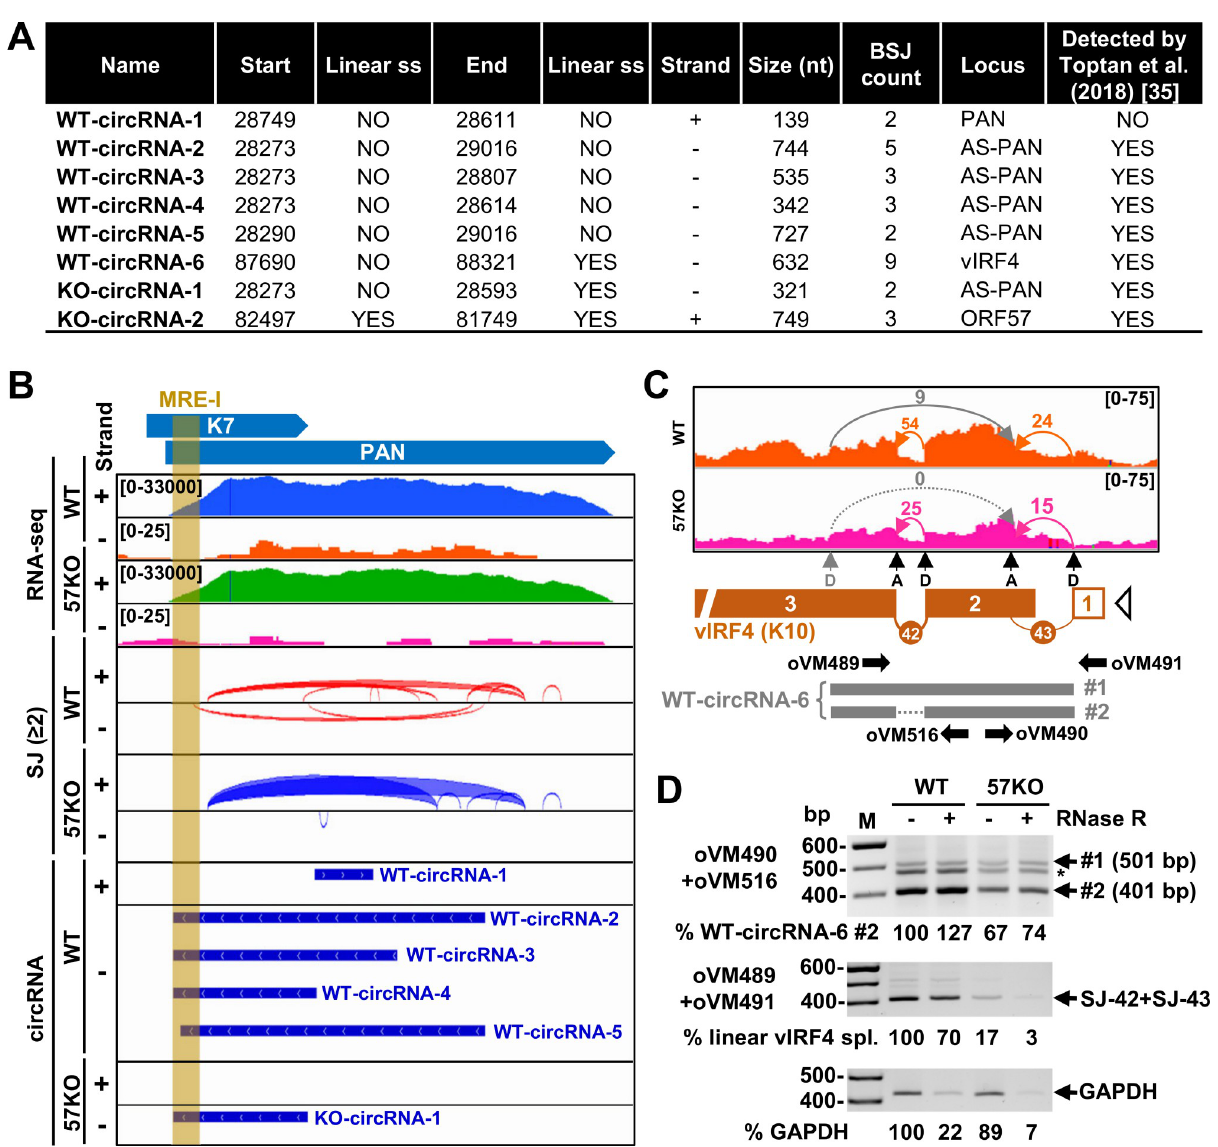
Fig 8. Linear RNA splicing and production of KSHV circRNAs. (A) Identification of KSHV circRNAs from RNA-seq in BCBL-1 cells with a WT or 57KO genome during lytic replication induced by 24 h valproic acid treatment using a circular RNA prediction software CIRI2 [38, 39]. (B) Distribution and coverage of RNA-seq reads on PAN, detected linear PAN RNA splice junctions (red and blue arches) with minimum 2 splice junction reads and predicted viral PAN circRNAs (thick blue lines, see panel A for details) in WT and 57KO BCBL-1 cells with lytic replication. MRE-I represents the Mta or ORF57-responsive element I in PAN RNA identified by anti-ORF57 CLIP [26]. (C) The RNA-seq reads mapped to KSHV vIRF4 (K10) locus in WT (orange) and 57KO (pink) cells with reads-coverage depth shown in the upper right corner. The arches show a direction and number of splice reads detected for linear canonical splicing (orange and pink arches) and back-splicing (grey arches). Below is a diagram of KSHV vIRF4 locus with detected exons (orange boxes), introns (numbered orange arches) with the corresponding splice sites (D = splice donor and A = splice acceptor). The open triangle represents a predicted transcriptional start site (TSS). Predicted unspliced and spliced forms of WT-circRNA-6 are shown in grey. The primers used to amplify linear and circular vIRF4 RNAs are shown as arrows. (D) The effect of 57KO on the production of vIRF4 linear and circRNAs. The total RNA from WT or 57KO cells isolated 24 h after induction of viral lytic cycle with or without RNase R digestion was used as a template to amplify circular vIRF4 RNA using a primer pair of oVM490 and oVM516 and linear spliced vIRF4 RNA using a primer pair of oVM489 and oVM491 as shown in the panel C. Host GAPDH RNA was amplified as an RNA loading control with the primer pair shown in the S6 Table . The percentage of individual RNA was calculated based on band signal density using ethidium bromide-stained agarose gels using ImageLab software (BioRad) with the amount of PCR products obtained from WT RNA without RNase R treatment set as 100%. The asterisk ( � ) indicates a heteroduplex band derived from two RT-PCR products as described [75].